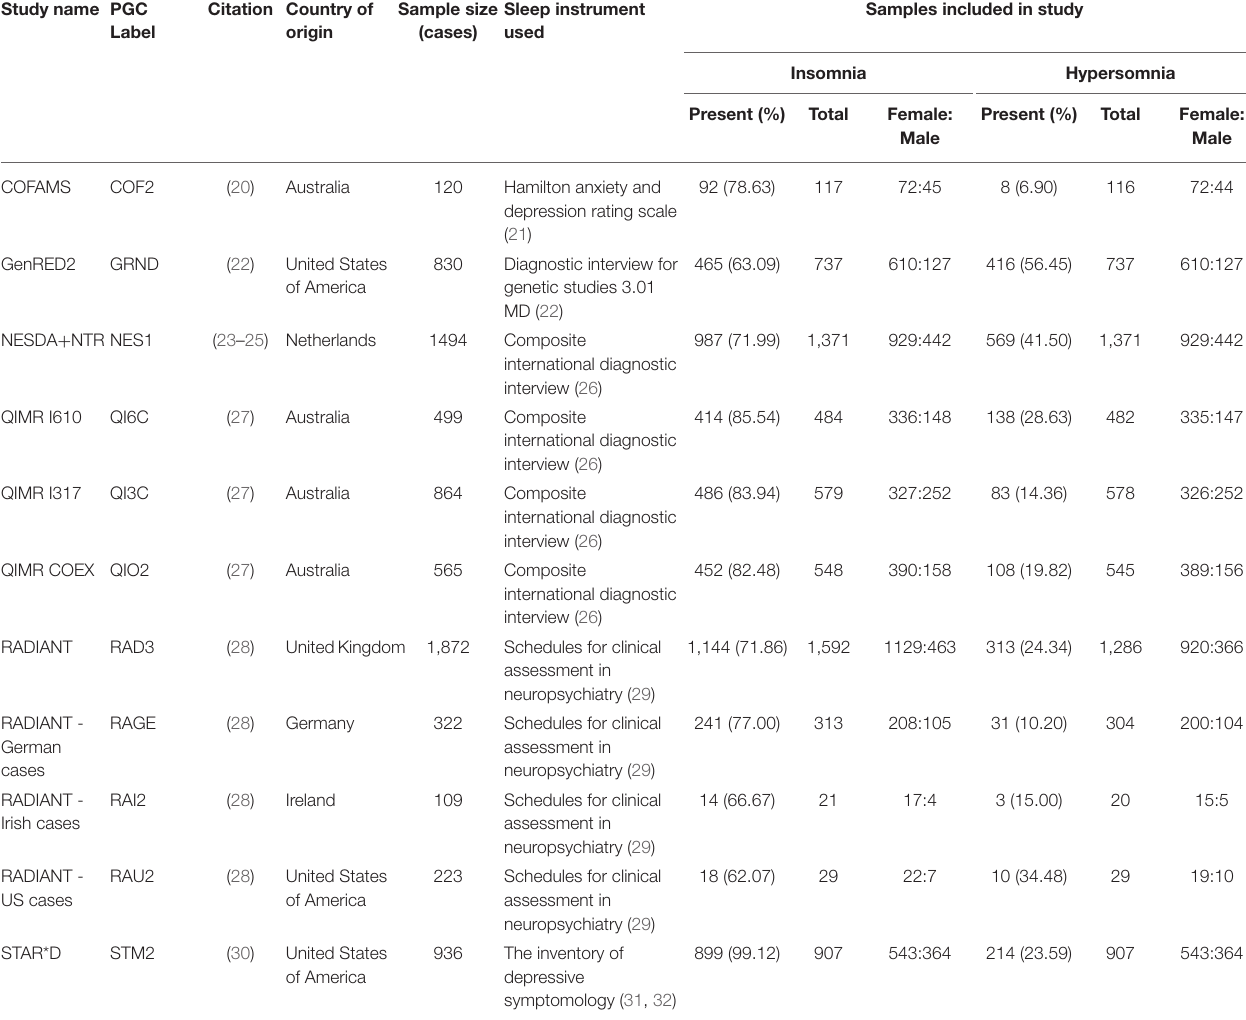
TABLE 1 | Sample distribution by